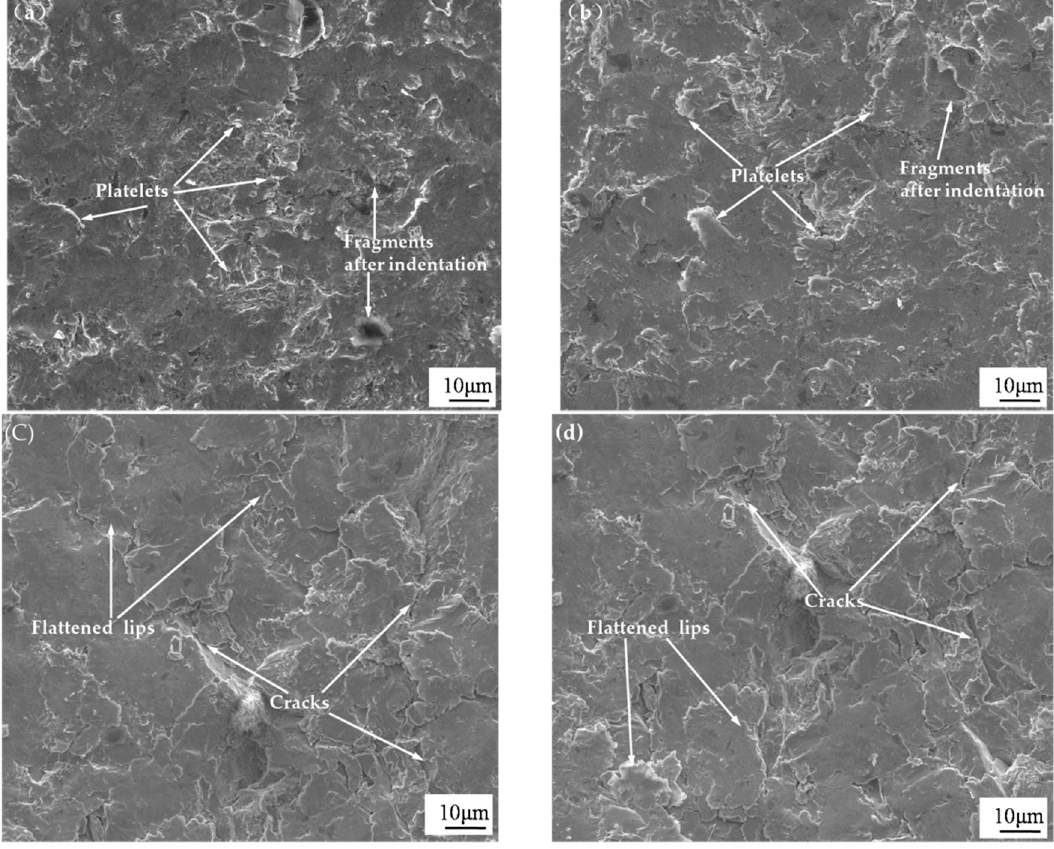
Figure 10. The eroded surface SEM micrographs of Al x CoCrFeNiTi 0.5 HEA coatings after 30-min slurry erosion: ( a ) Al 1.0 ; ( b ) Al 1.5 ; ( c ) Al 2.0 ; and ( d ) Al 2.5 at 10.08 m/s, 1.0 wt. % sand concentration and 90° impingement angle.